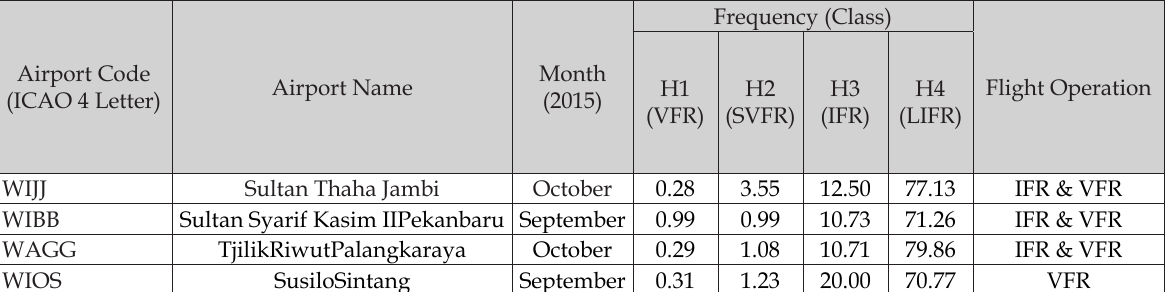
Table 3. Visibility Class Frequency at very high VSI (Sources: data analysis and Indonesian aerodrome/airport chart legend (INDOAVIS